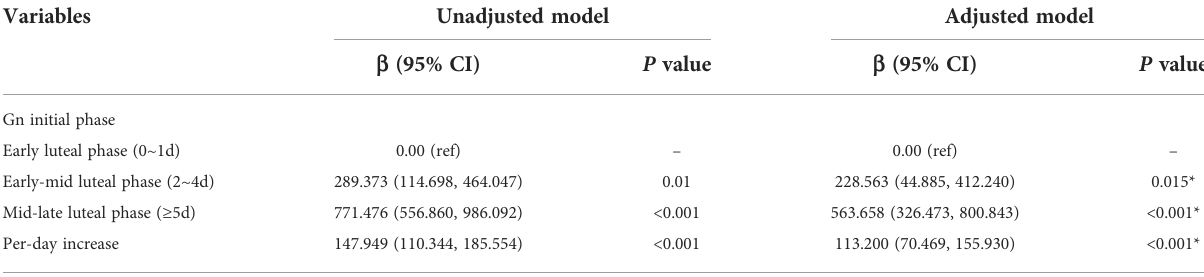
TABLE 3 Association between day of gonadotropin start and total gonadotropin dosage in patients with luteal phase